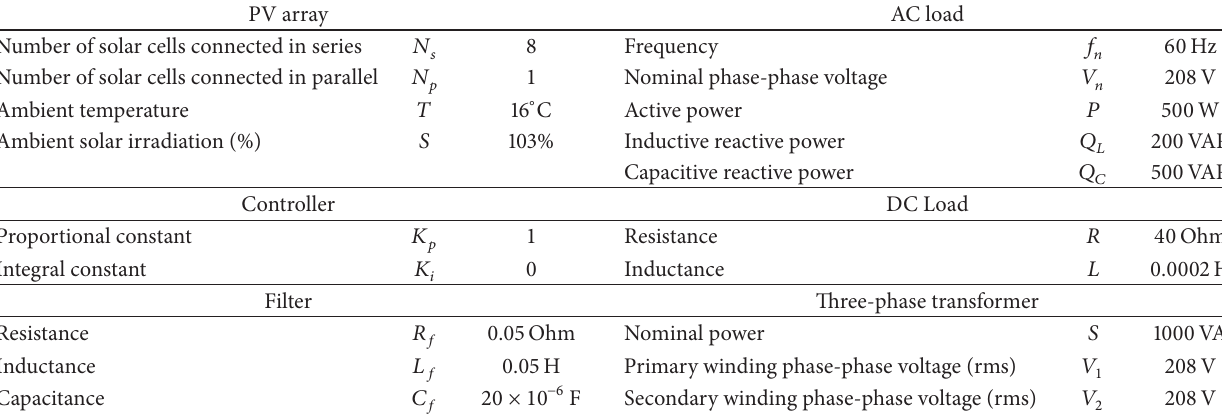
Table 4: The PV powered AC load experiment